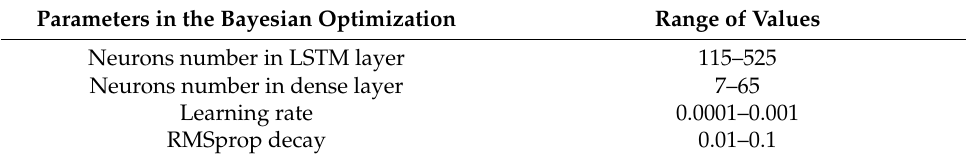
Table 3. The range of hyperparameters.